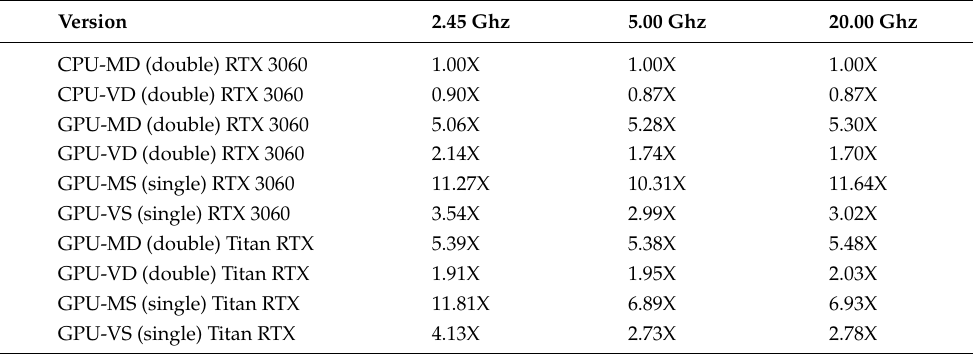
Table 7. Speed-up factors calculated using as a base the utilized execution time by CPU-MD, for the open free space